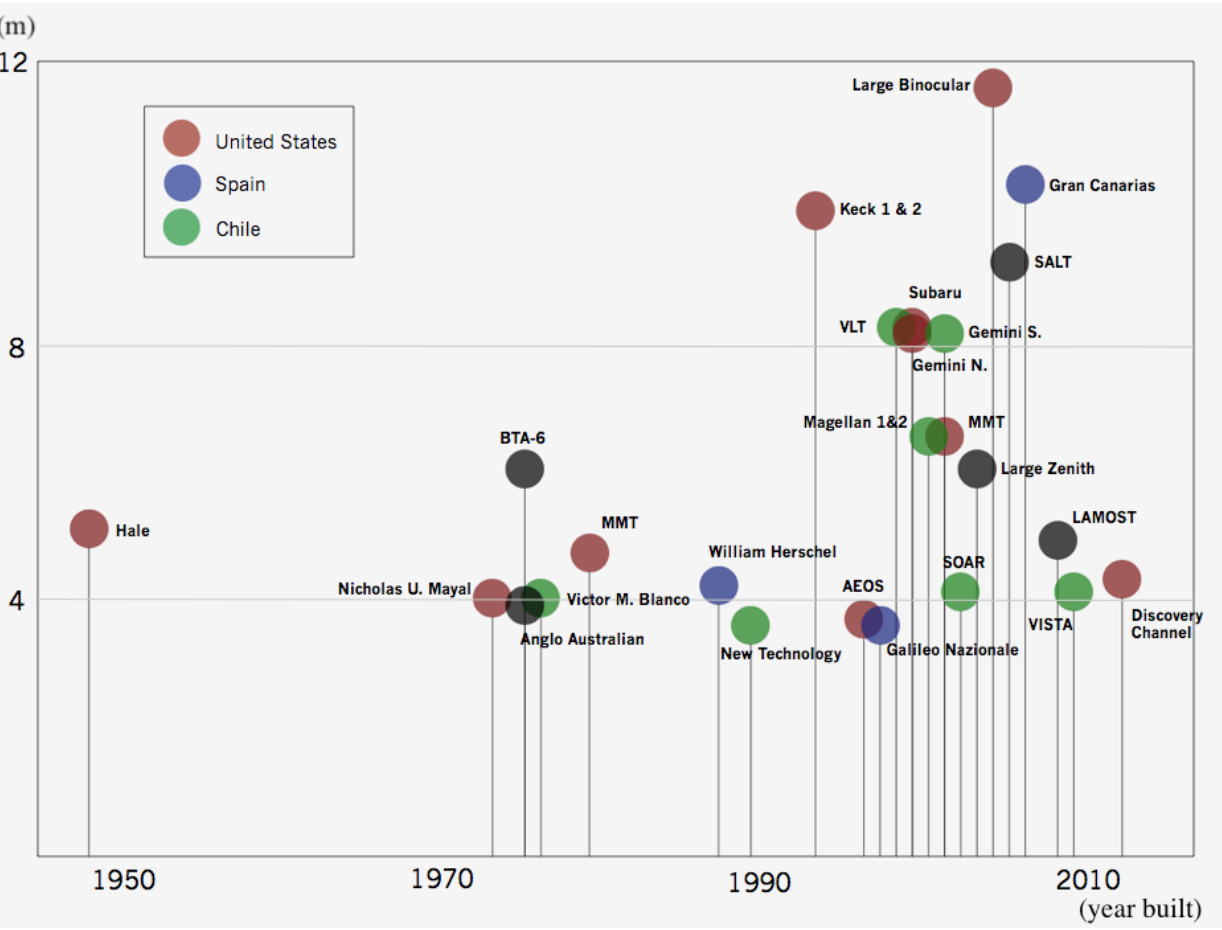
Figure 1. Development trend of large aperture telescopes.